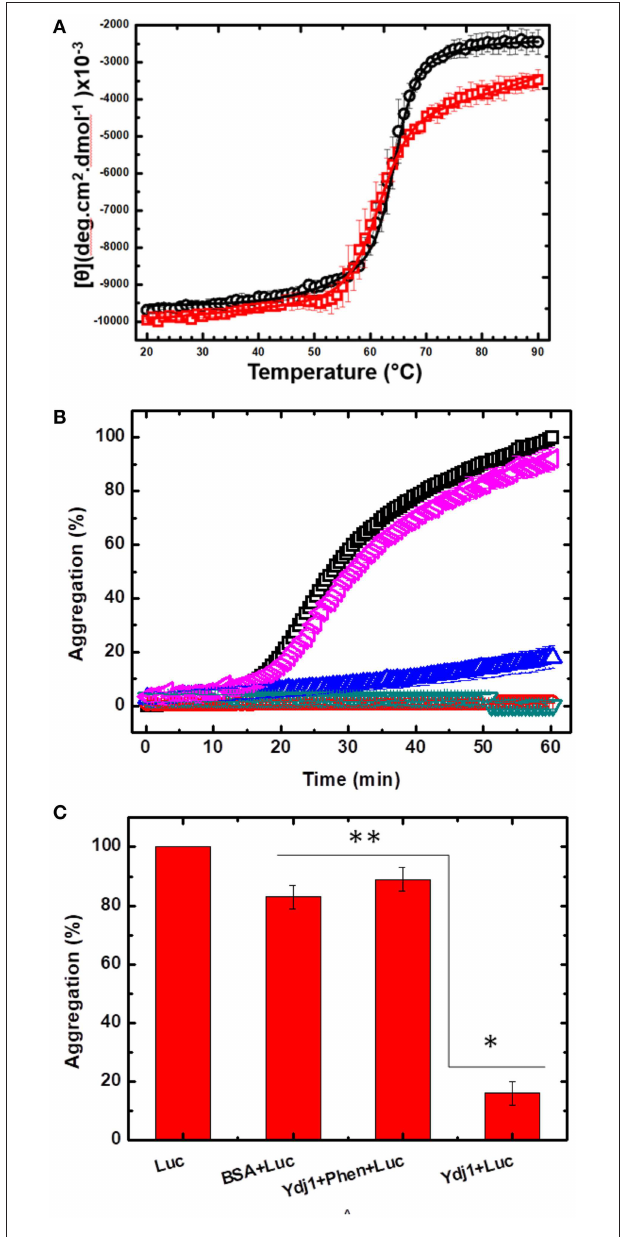
FIGURE 5 | The effect of Zn removal on the stability and chaperone function of Ydj1. (A) Heat-induced unfolding was measured by heating Ydj1 before (red squares) and after (black circles) the Zn removal procedure; the samples were heated from 20 to 90 ◦ C, and the CD signal was measured at 222nm. Data were fitted using Origin. (B) Chaperone activity. Luciferase aggregation at 37 ◦ C was monitored by light scattering (turbidity) (black square). Ydj1 alone, either before (red inverted triangle) or after (green inverted triangle) the Zn removal process remains folded during the process. Ydj1 before (blue triangle) the Zn removal process protected luciferase against aggregation but did not after (pink inverted triangle) the Zn removal process. (C) Bar chart summarizing the protection efficiency of Ydj1 before and after Zn removal, using luciferase as the client protein, against aggregation during heat at 37 ◦ C for 60min [as shown in (B) ]. * p > 0.05 and ** p < 0.05. Bovine serum albumin (BSA) was used as a control, showing that the mere mixture with any polypeptide did not prevent protection against aggregation.